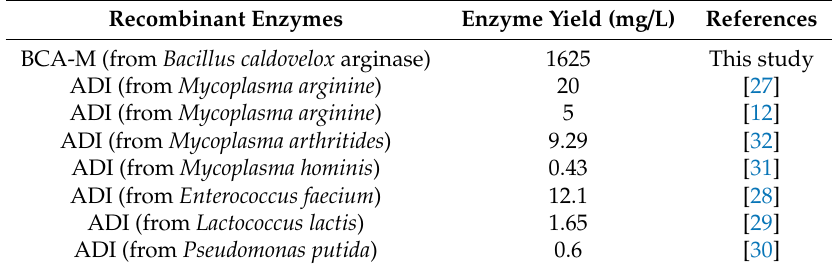
Table 3. The comparison of the enzyme yields between BCA-M and